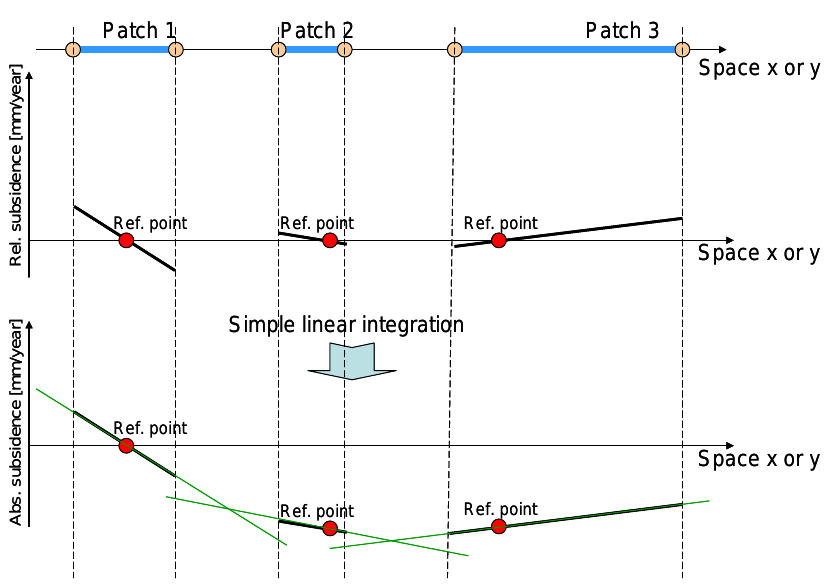
Figure 2: A simple 1D example of integrating the relative deformation of the various patches to get the absolute